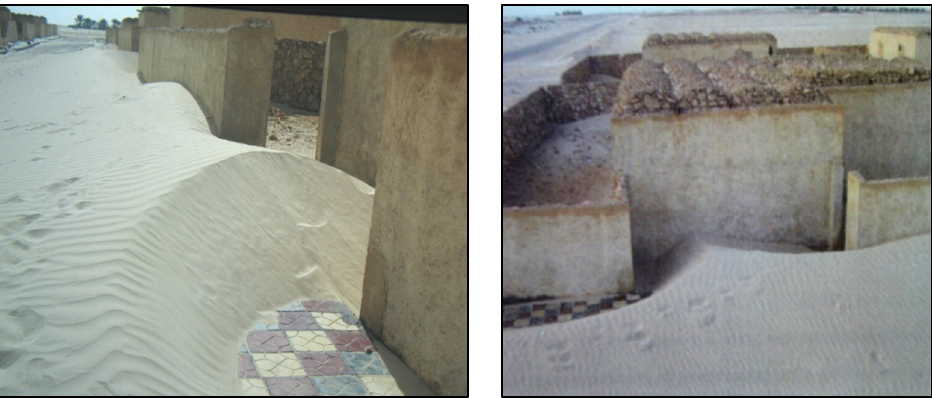
Figure 3. Sand encroachment on a new housing project in the region of El-Oued Souf, Algeria. (Photos: M. Sherzad).